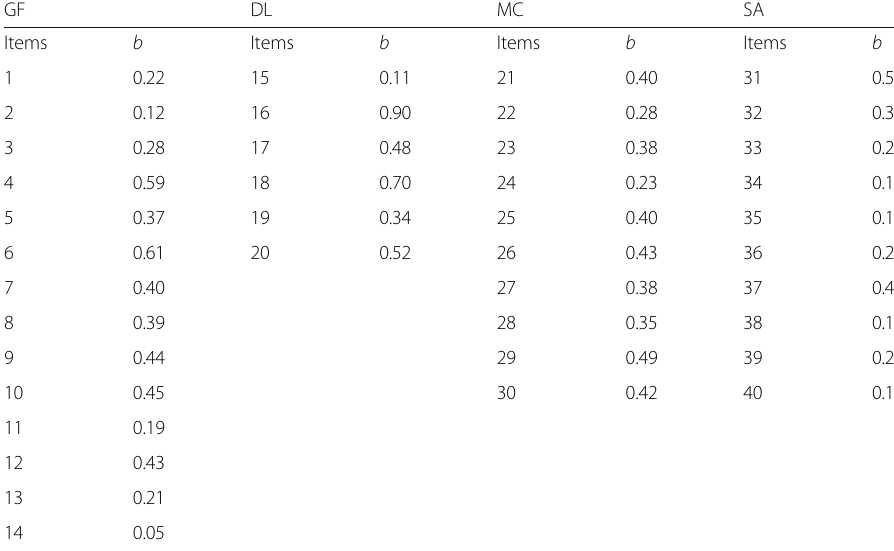
Table 6 Standardized regression weights of IELTS listening comprehension test